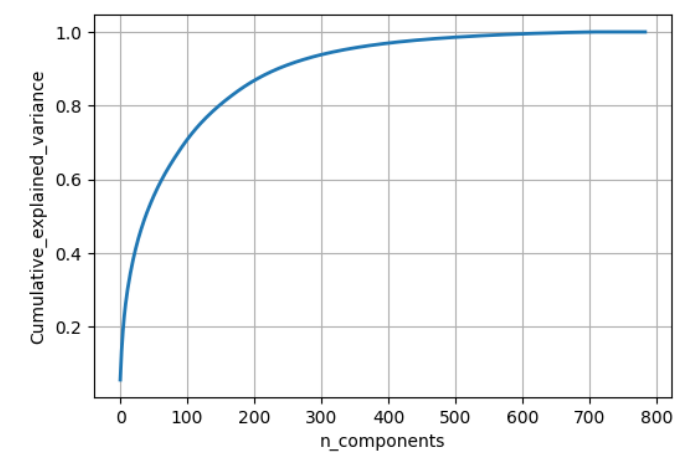
Figure 7 – Cumulative sum of variance with the components Рис. 7 – Совокупная сумма дисперсии с компонентами Слика 7 – Кумулативни збир варијансе са